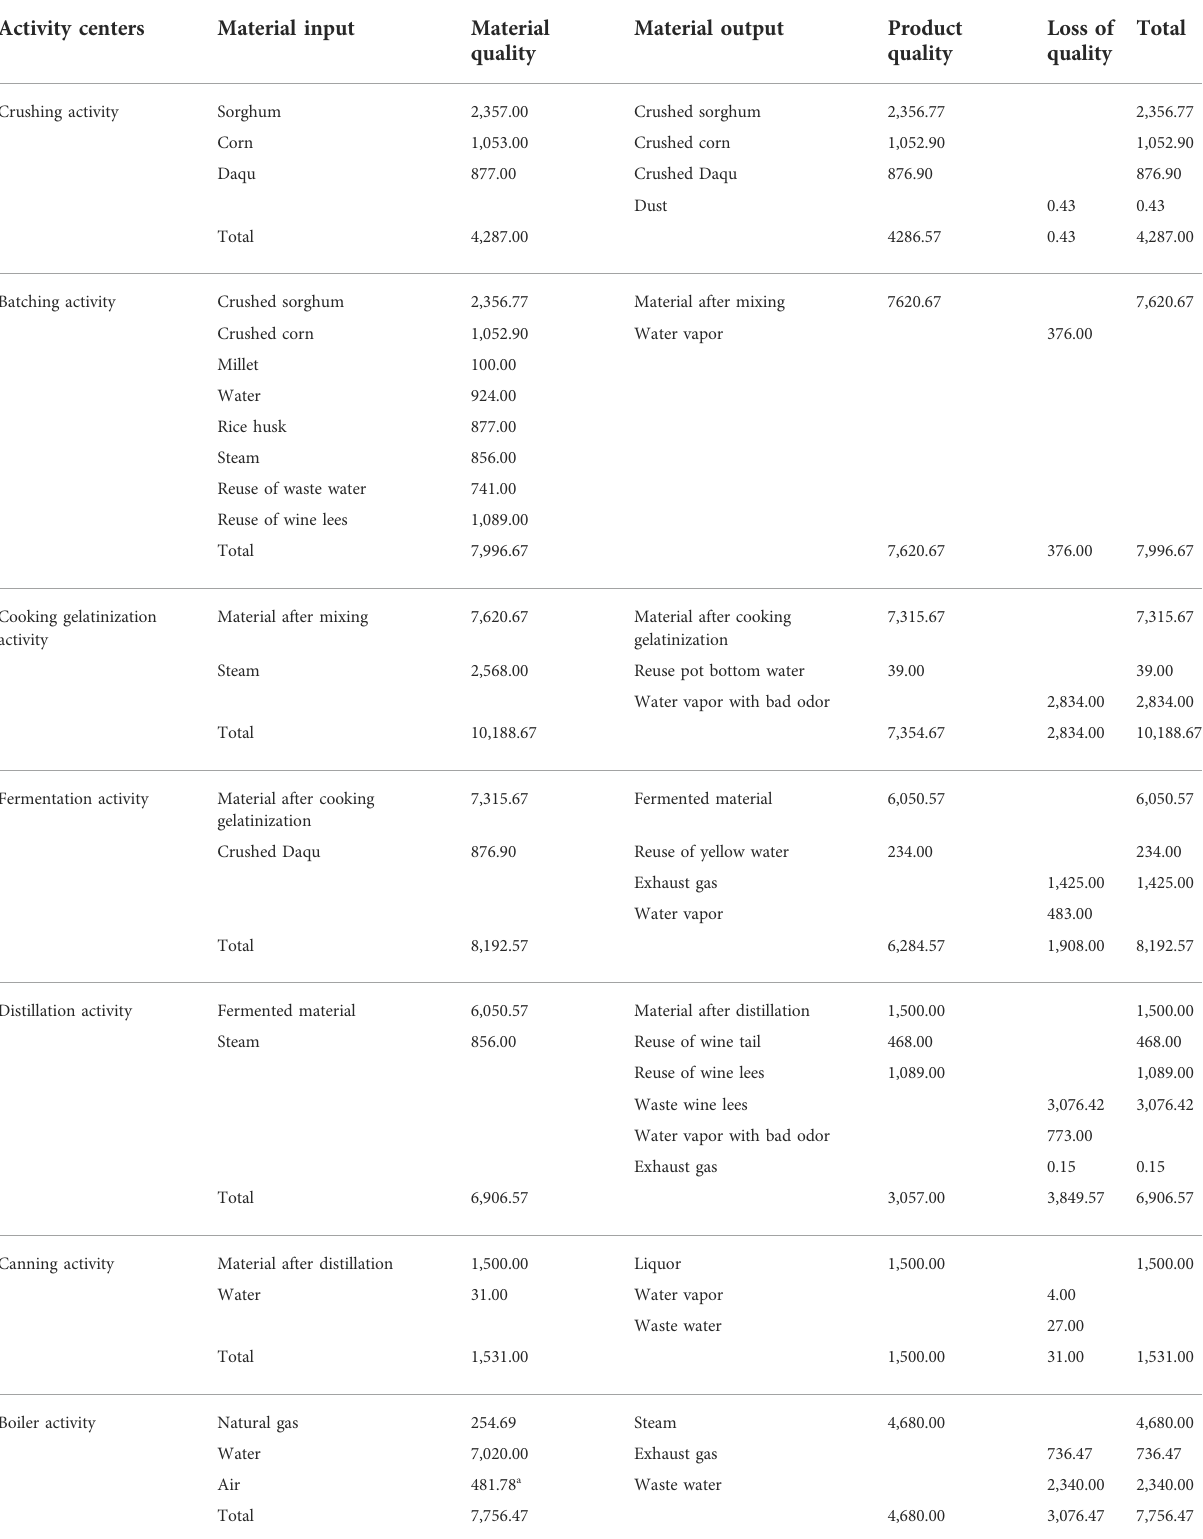
TABLE 5 Balance of Material input and output budget Unit: